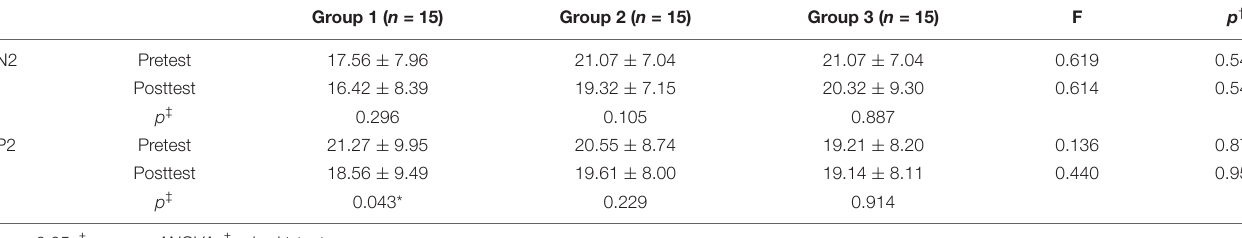
TABLE 2 | N2 and P2 amplitudes before and after interventions [X ± SD ( µ V)].